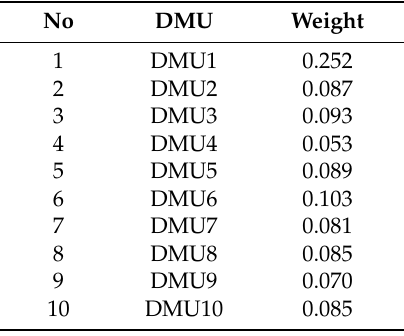
Table 4. The weight of each